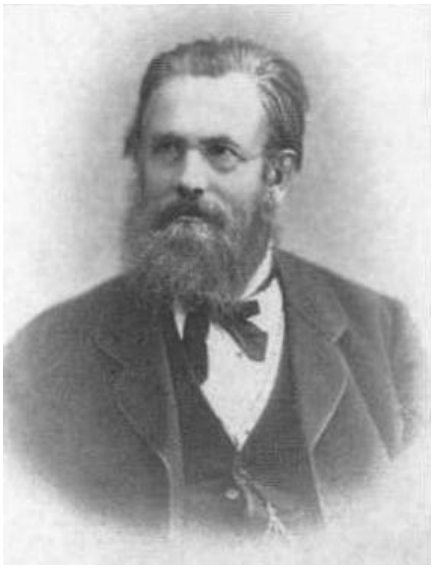
Figure 1. Ivan Vasylyovych Vernadsky (1821–1884),